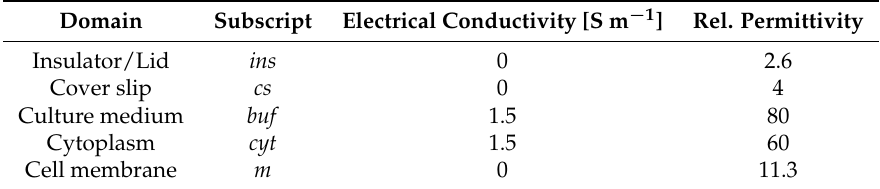
Table 2. Parameters for the numerical model based on